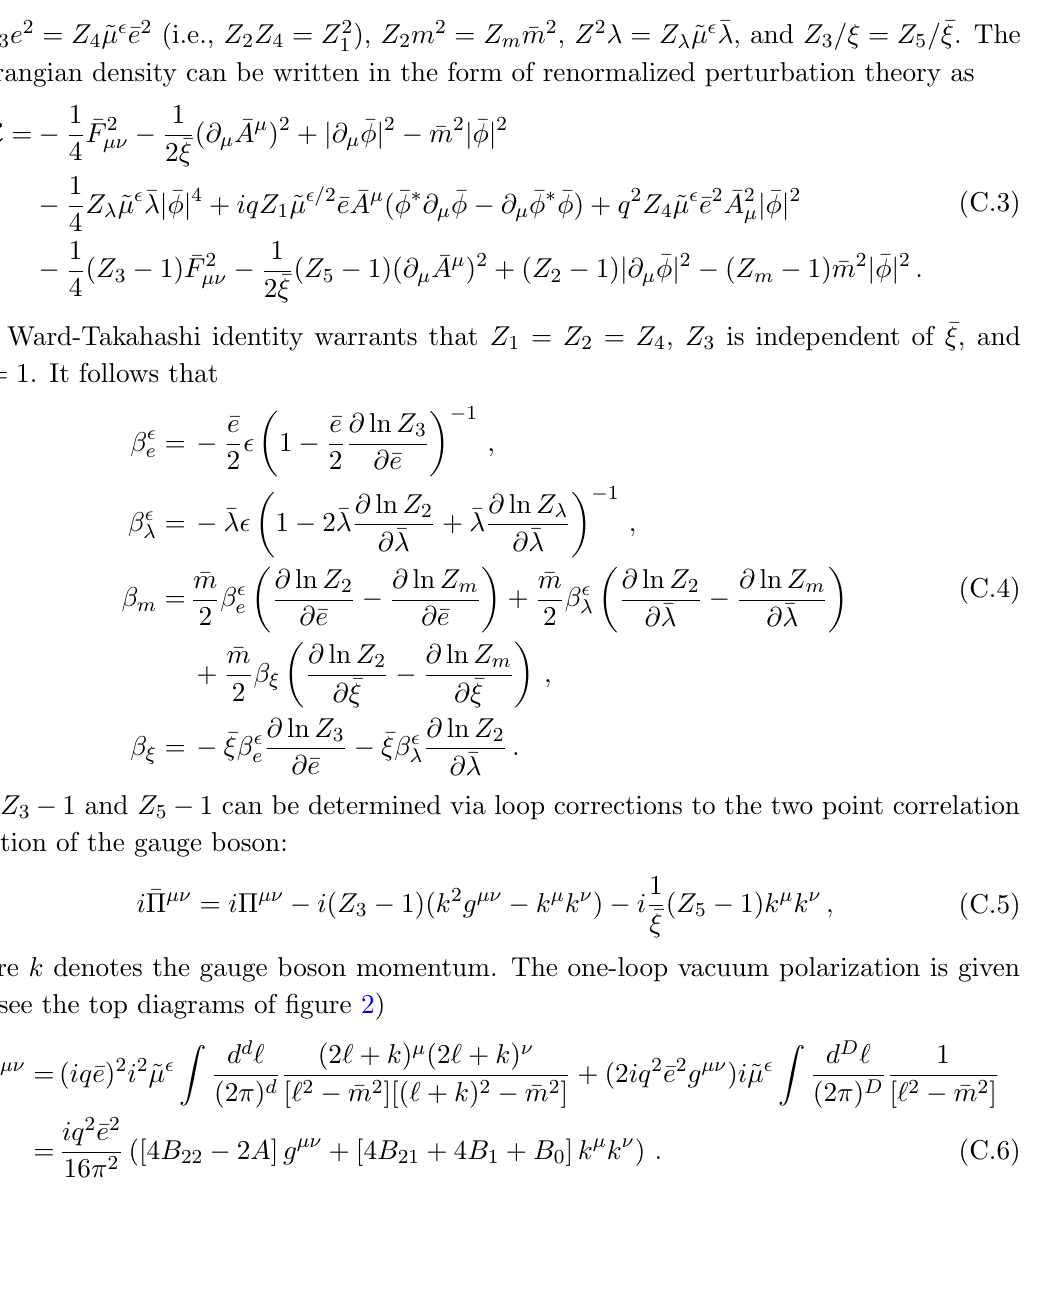
Figure 2 . Leading contributions to the vacuum polarization i (cid:22)(cid:5) (cid:22)(cid:23) . [Top] scalar loop. [Bottom] counter